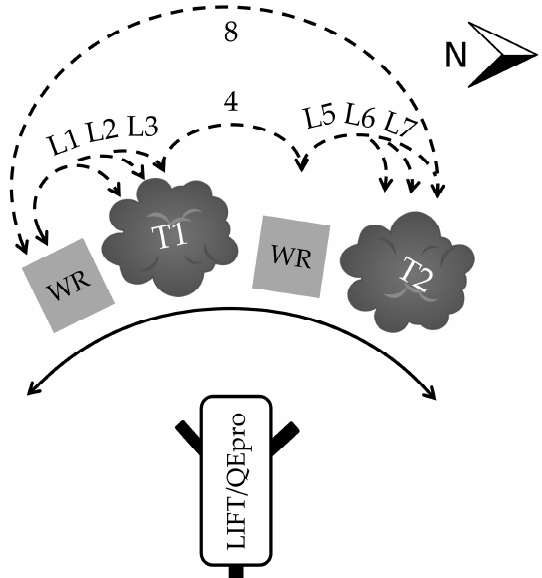
Figure 1. Nadir perspective of the diurnal measurement set-up with the Light Induced Fluorescence Transient instrument (LIFT) and QE Pro mounted on a motorized tripod and successively panned between two white reference panels (WR) and six different leaves on two trees (T1 and T2). The solid arc indicates the movement range of the tripod mounted LIFT and QE Pro. Broken arcs indicate the movements for successive measurements, where each arc indicates a single panning movement from WR to leaf and back to WR. The number labels on the broken lines indicate the sequence of panning movements, with those proceeded with an “L” indicating panning motions where leaf measurements occurred.